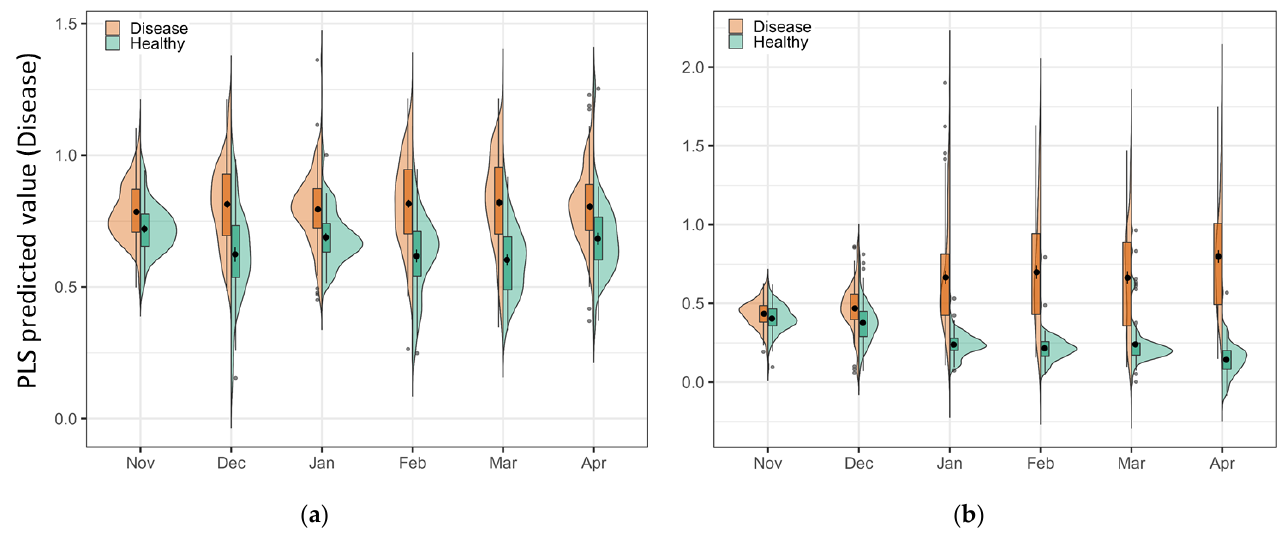
Figure 6. The combined violin plot and box plot of the predicted value of disease from the PLS-DA model for ( a ) Chardonnay, and ( b ) Pinot Noir at each timepoint. The larger the value, the higher the probability of a sample belonging to a diseased vine, and the smaller the value, the lower the probability of a diseased vine. In this binary model, a low value means the sample more likely belongs to a healthy vine. The greater the separation between actual disease and healthy samples, the better the performance of the classification model.